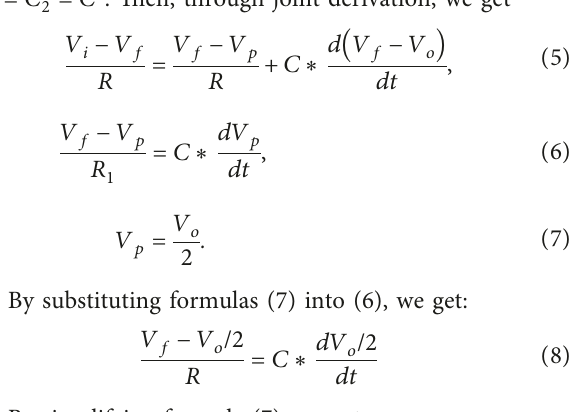
Figure 1: Negative exponential signal generation